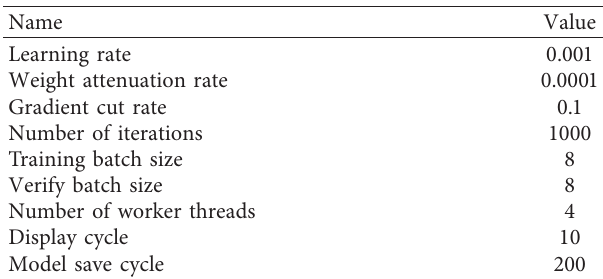
Table 6: Network training parameter